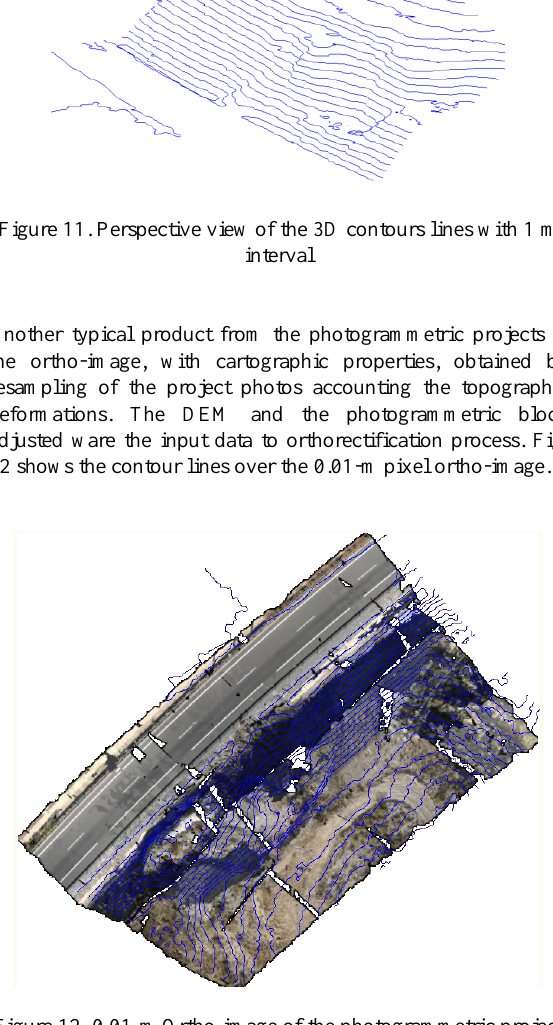
Figure 12. 0.01-m Ortho-image of the photogrammetric project with the contour lines